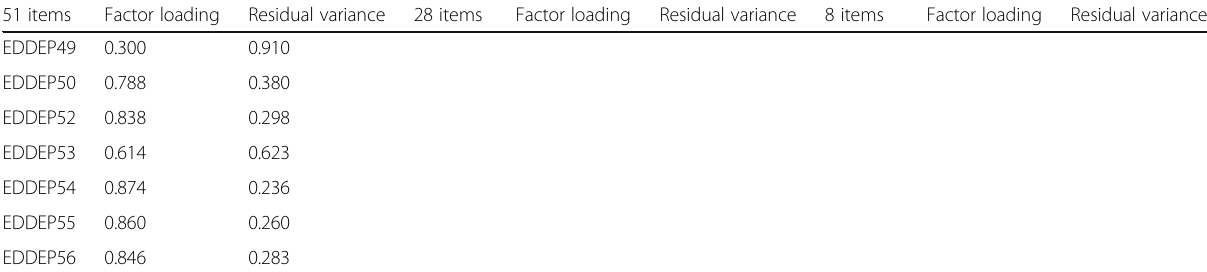
Table 3 Factor loadings for the unidimensional factor models of the PROMIS Depression Item Bank